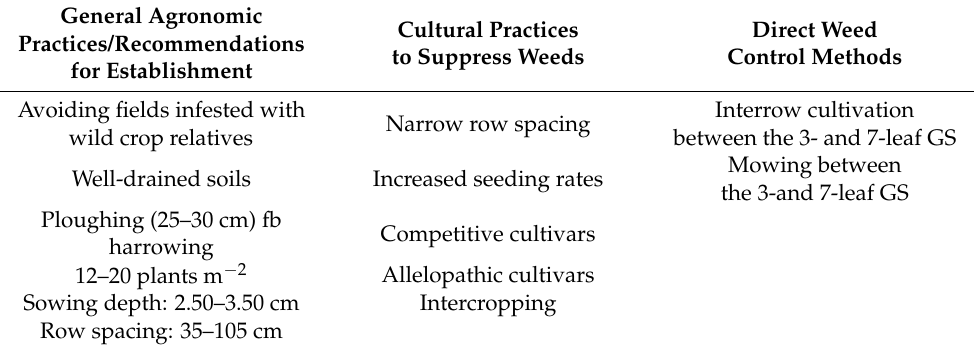
Table 5. General agronomic practices and recommendations for sweet sorghum establishment, cultural practices to suppress weeds and direct weed control